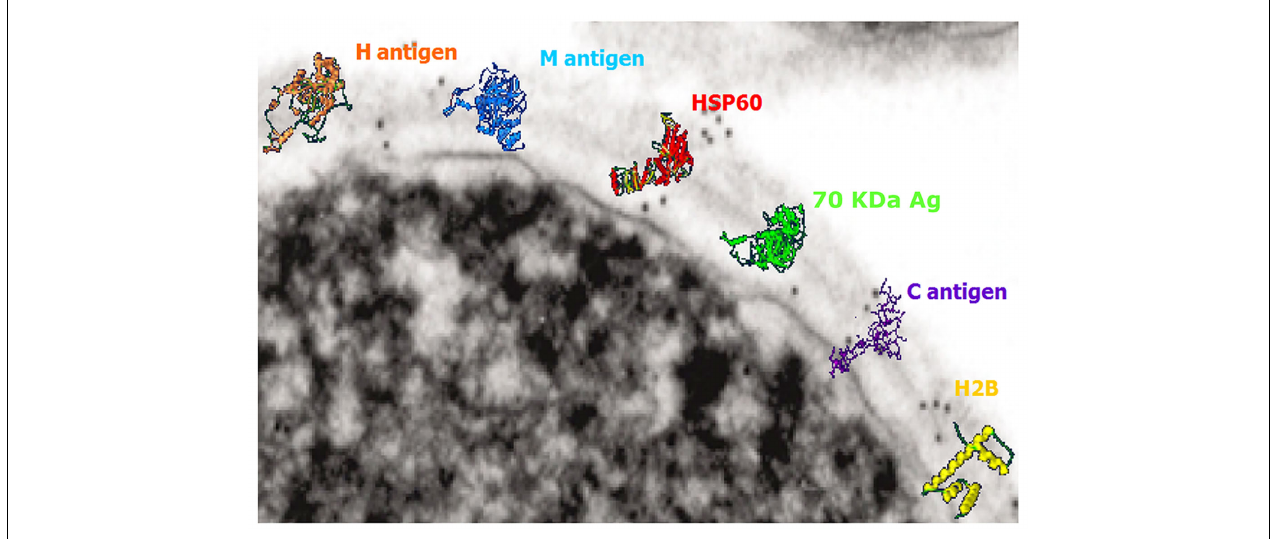
protein 60, 70kDa antigen, C antigen, and histone 2B. The antigen structures are based on molecular modeling as described in Guimaraes et al.